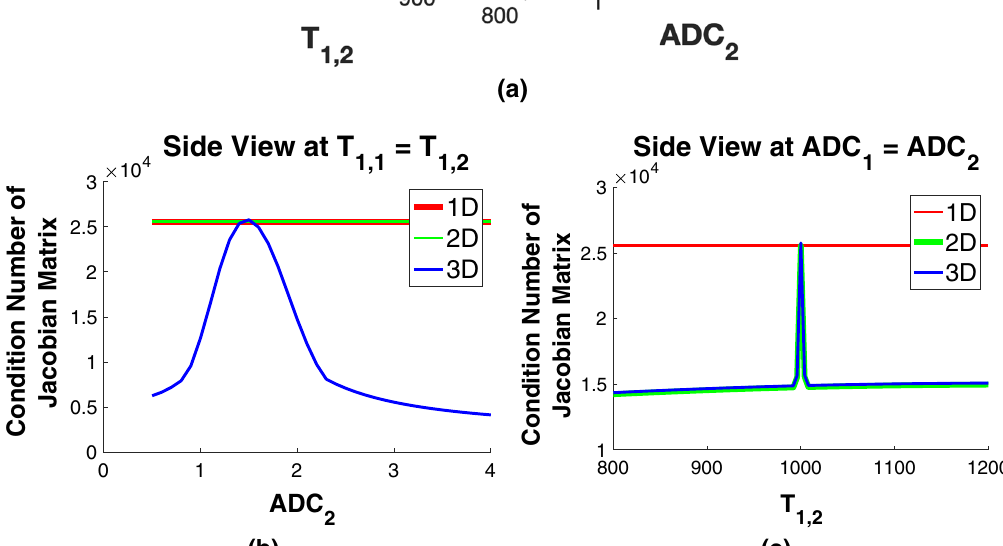
ADC 2 for the case = ADC ADC 1 2 =